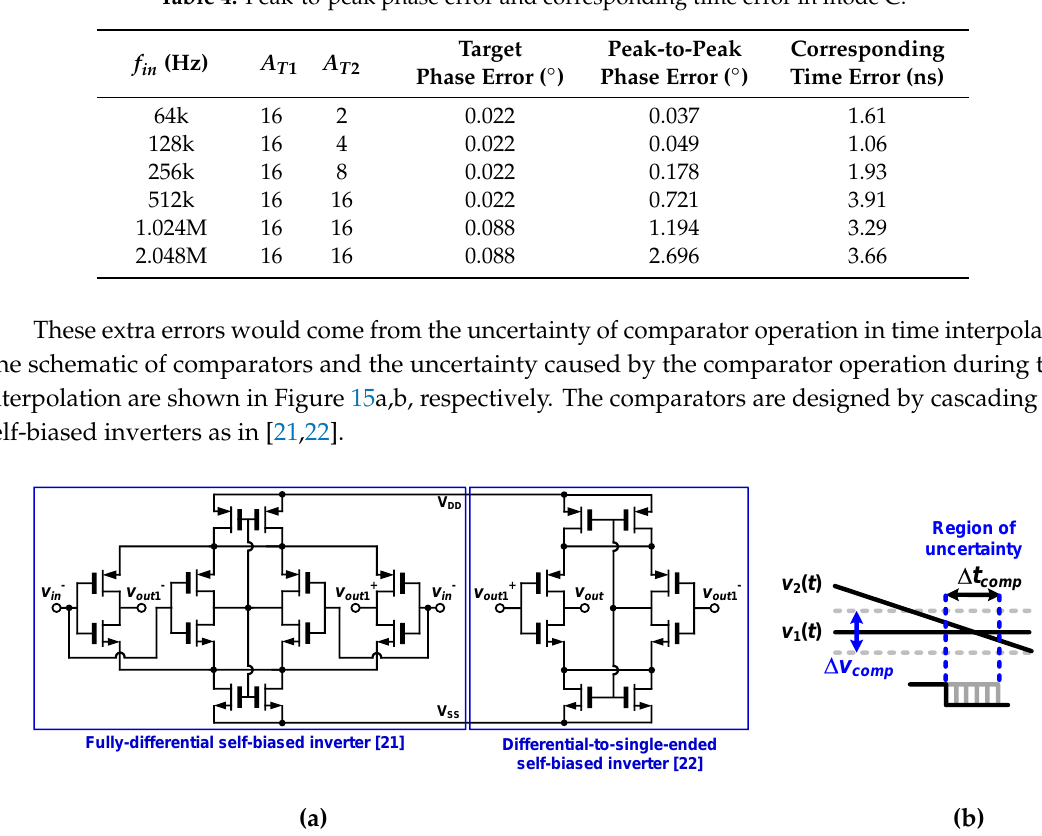
Table 4. Peak-to-peak phase error and corresponding time error in mode C.